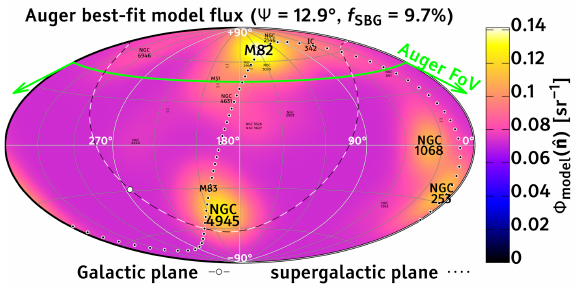
Figure 2. The flux map in the best-fit model of Ref. [1]